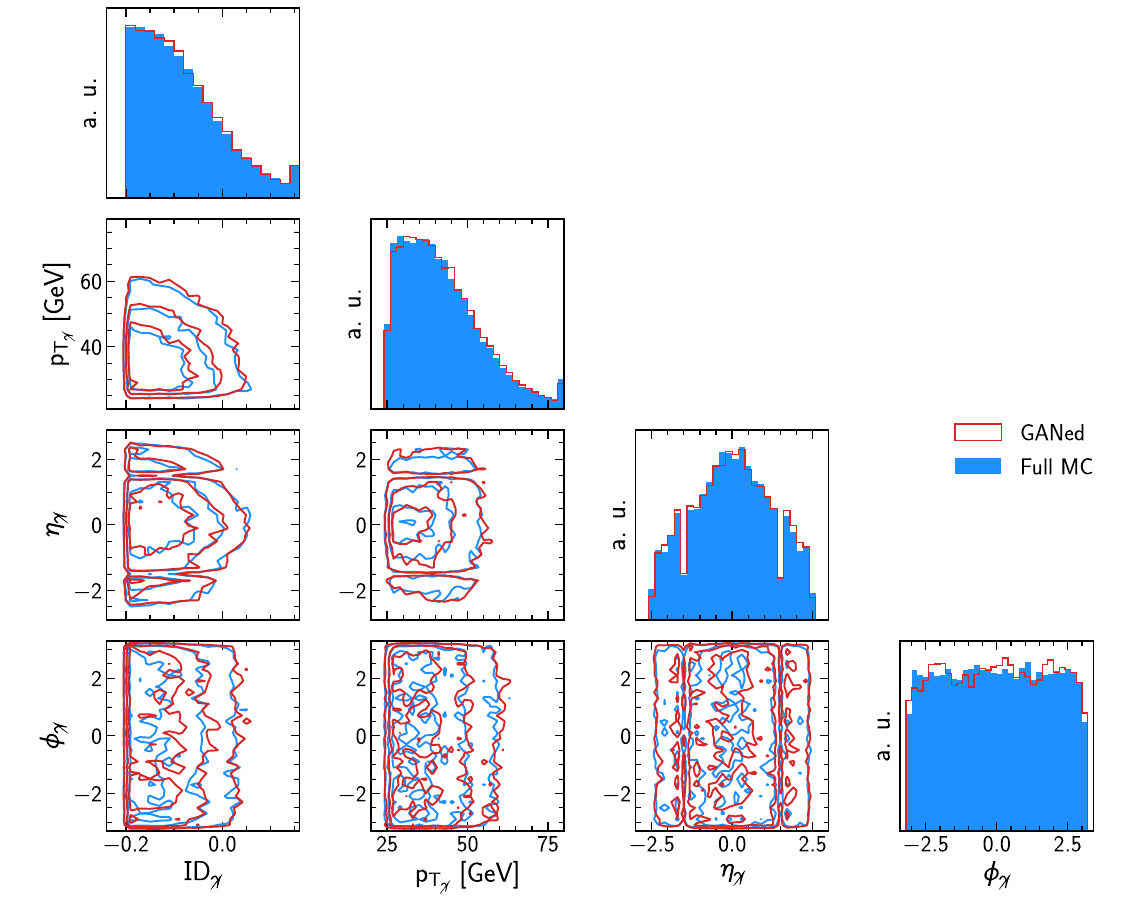
Fig. 6 Diagonal: comparison of the misidentified photon-observable distributions from the MC SR (named Full MC) and from the application of the GAN to the MC CR (named GANed). Off diagonal: Contour lines containing 25%, 50% and 75% of the events and showing correlations between pairs of